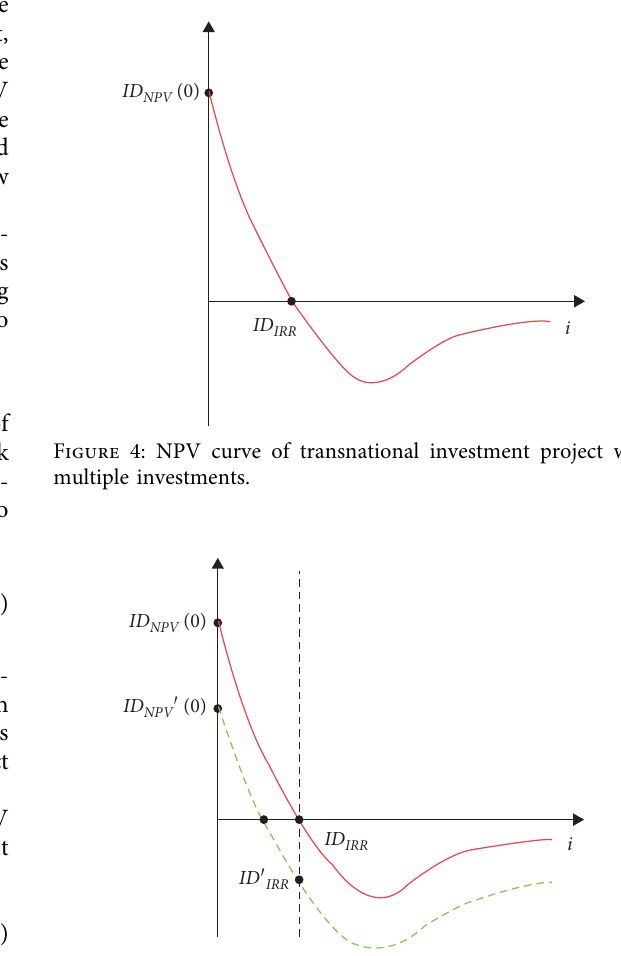
Figure 5: NPV curve of transnational investment project with multiple investments under decreasing